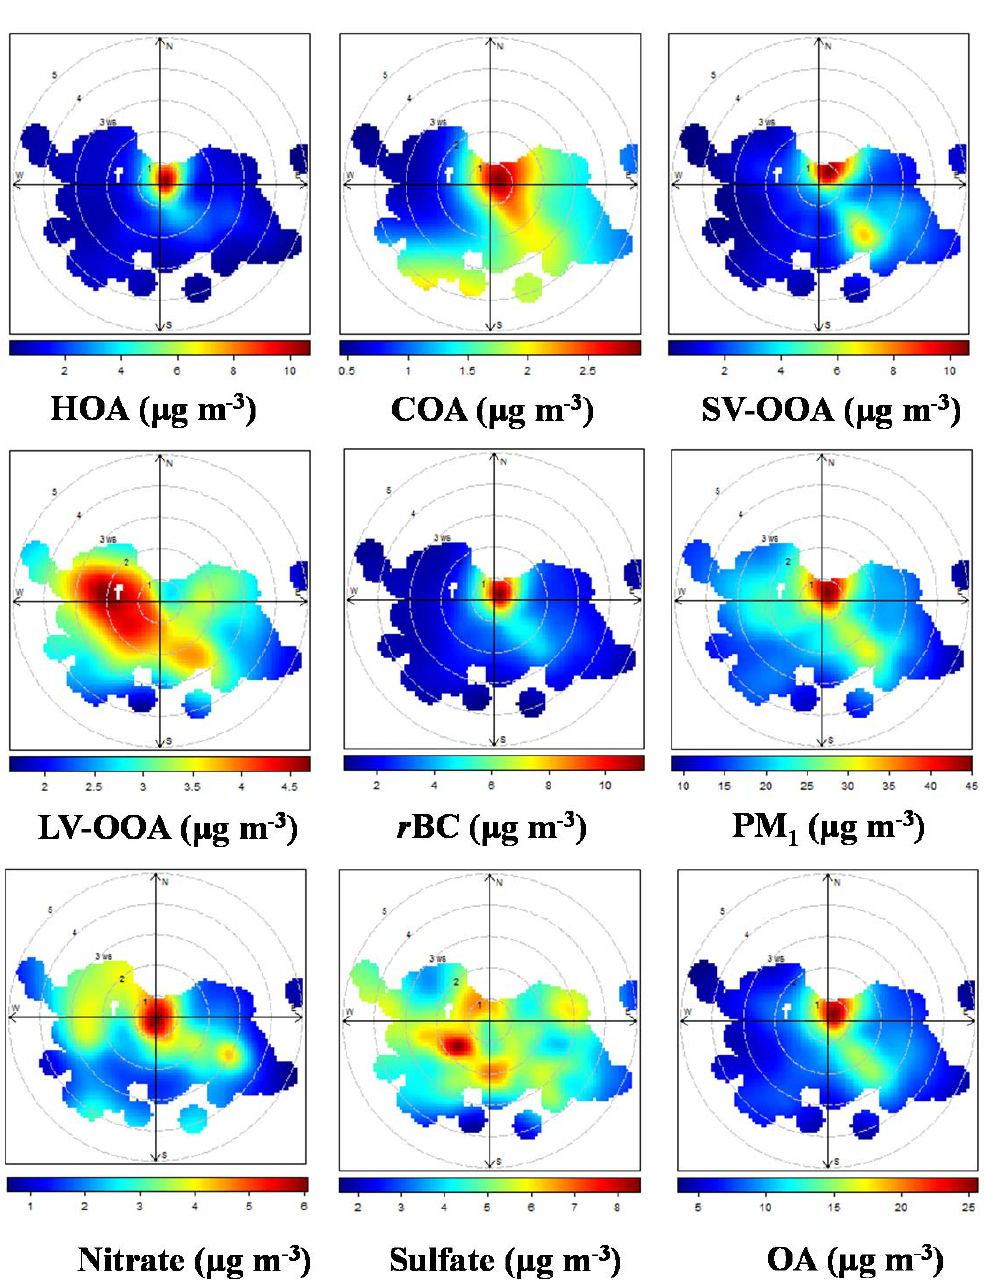
Figure 11. Bivariate polar plots of HOA, COA, SV-OOA, LV-OOA, r BC, PM 1 , nitrate, sulfate, and the total OA (the color scale shows the concentration of each species, and the radical scale shows the wind speed that increases outward from the center).